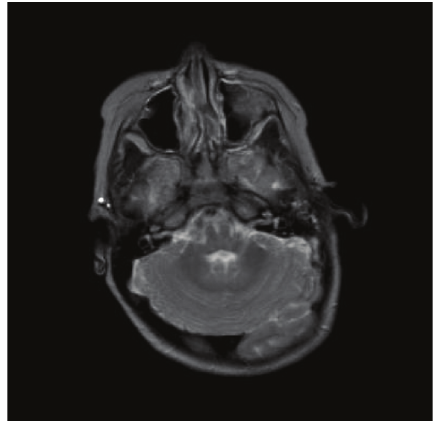
Figure 2: Magnetic resonance axial T2-weighted imaging in a patient with rhombencephalosynapsis shows fusion of the vermis and cerebellar